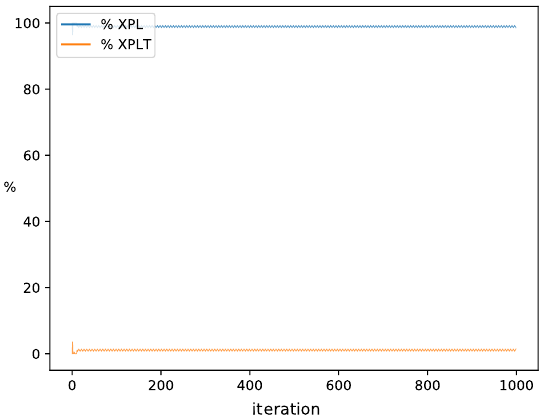
Figure 14. WOA—Exploration and Exploitation Graphic of 58 version MIR2.